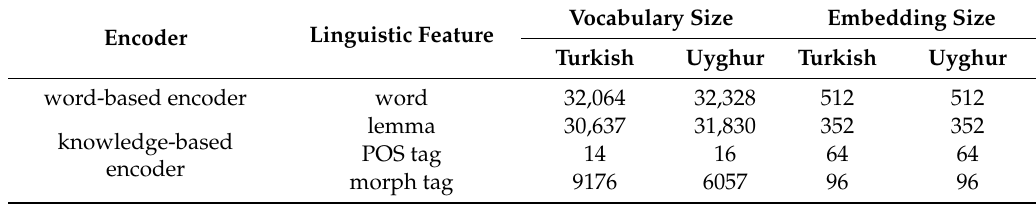
Table 4. The vocabulary and embedding sizes for the source-side Turkish and Uyghur translation.